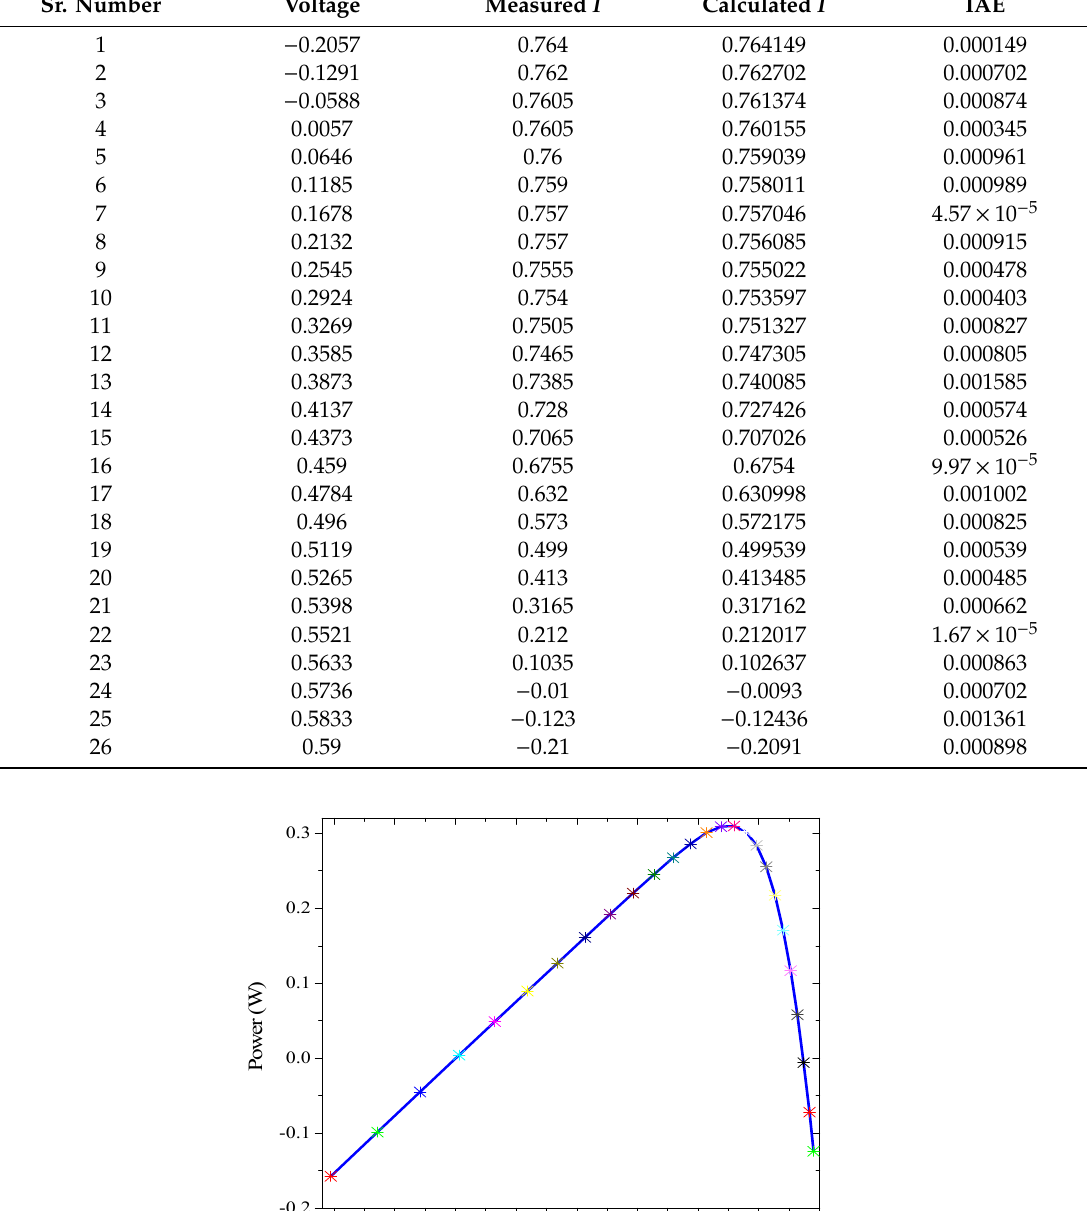
Table 3. I–V values and relative individual absolute error (IAE) for the single-diode cell.